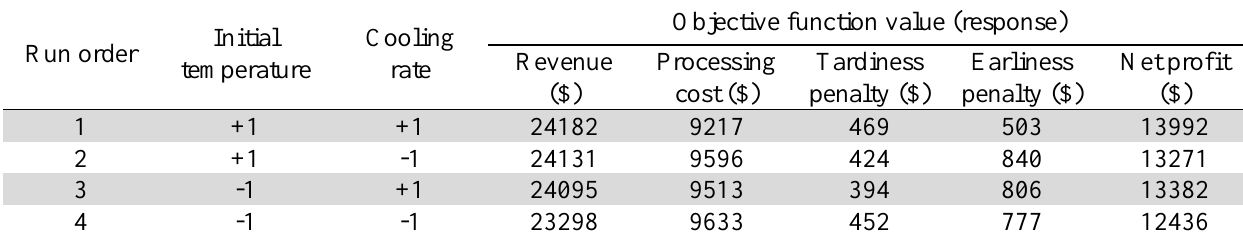
Experimental Results of the SA Algorithm for Parameter Tuning